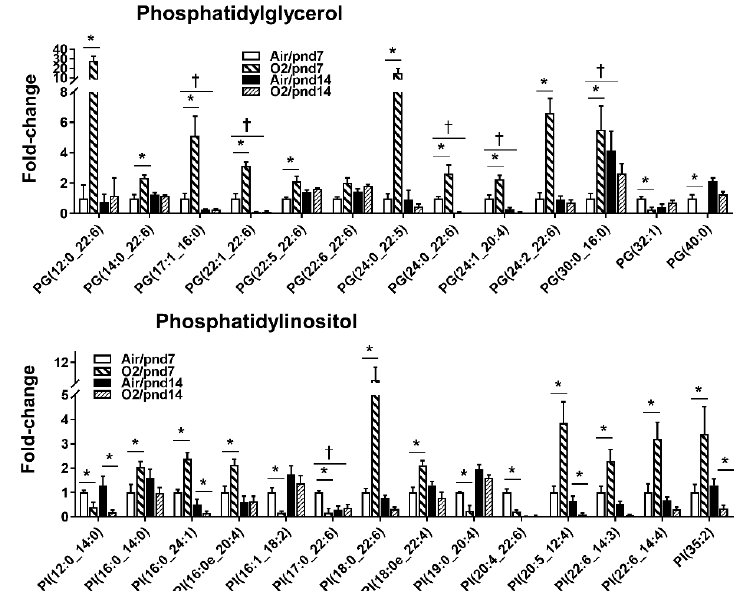
Figure 5. Compositional changes of lung PG and PI species in mice exposed to hyperoxia as neonates. PG and PI species in mouse lungs with 2-fold change and p < 0.05 between air and hyperoxia groups at pnd7 and pnd14 were listed. n = 6. * p < 0.05 vs. corresponding air; † p < 0.05 vs. air/pnd7 .